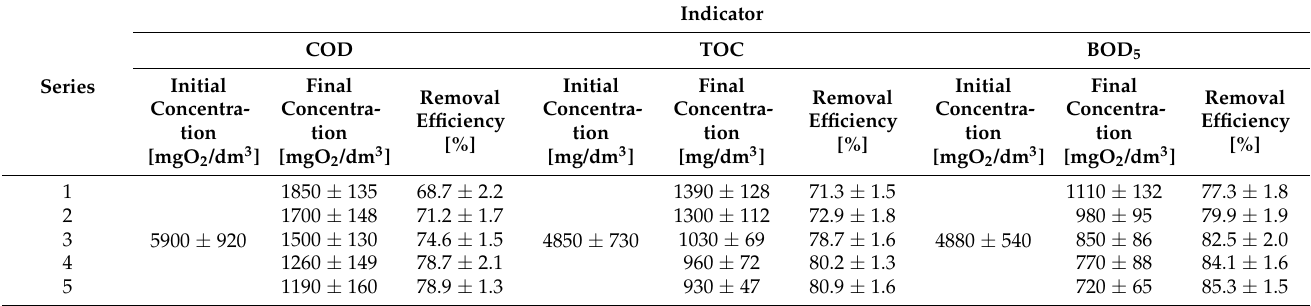
Table 6. Efficiency of removal of organic compounds from acid whey in particular experimental